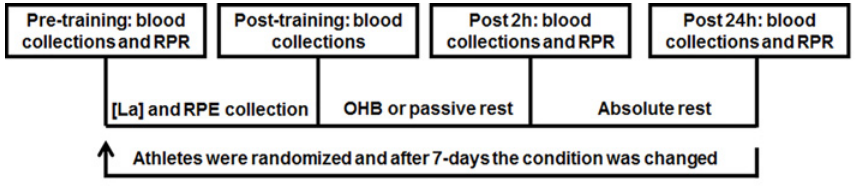
Fig 1. Experimental design. Note: [La] = Blood Lactate; RPE = Rating of perceived exertion (Borg 6 – 20); RPR = Rating of perceived recovery (0 – 10); OHB = hyperbaric oxygen therapy.